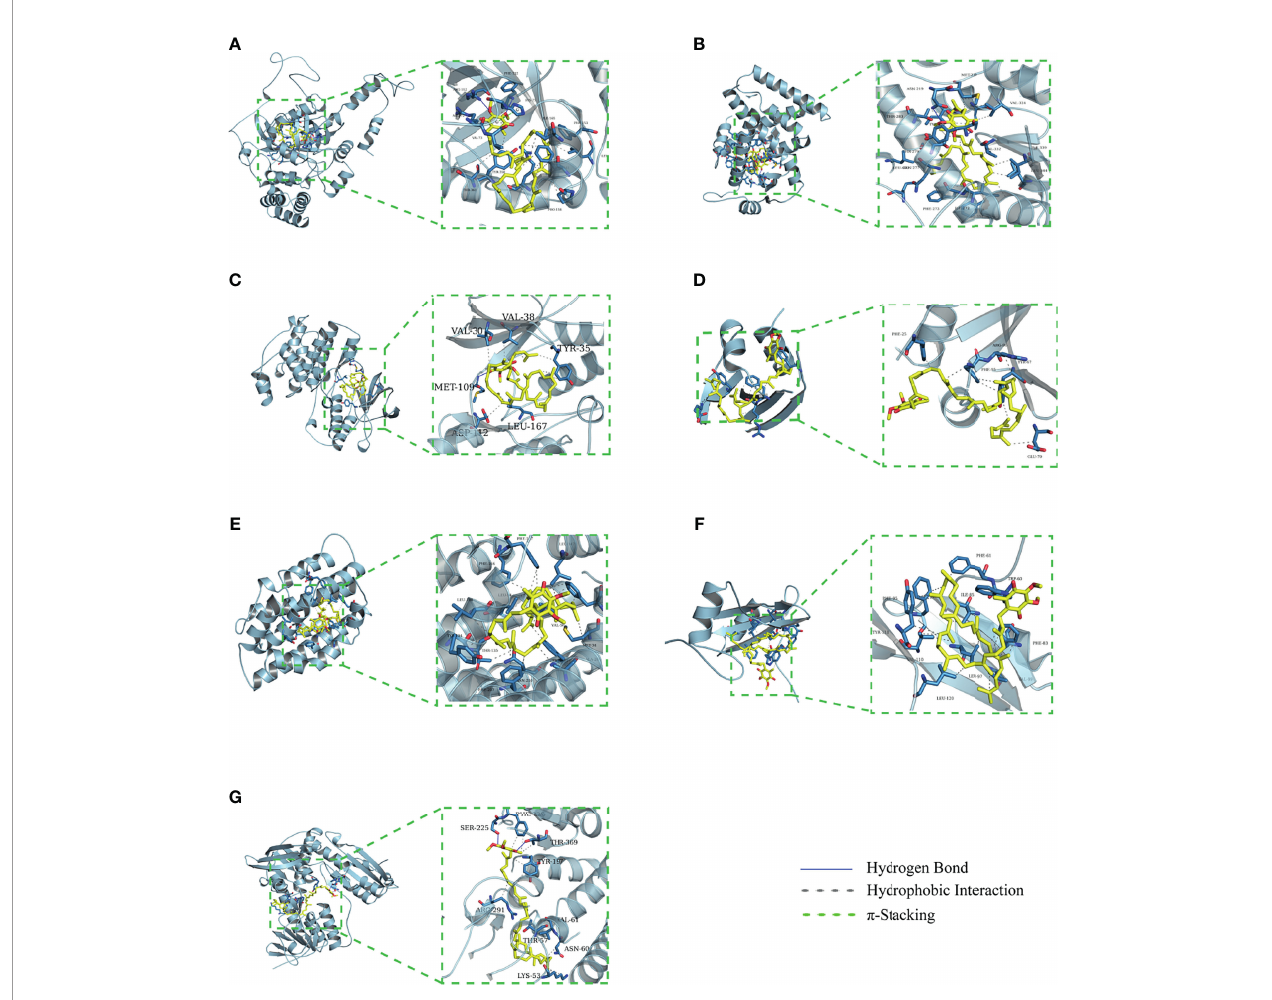
FIGURE 5 | Molecular docking of 7 hub targets with CoQ10. (A) The binding poses of CAT complexed with CoQ10. (B) The binding poses of PPARA complexed with CoQ10. (C) The binding poses of MAPK14 complexed with CoQ10. (D) The binding poses of SQSTM1 complexed with CoQ10. (E) The binding poses of HMOX1 complexed with CoQ10. (F) The binding poses of GRB2 complexed with CoQ10. (G) The binding poses of GSR complexed with CoQ10.